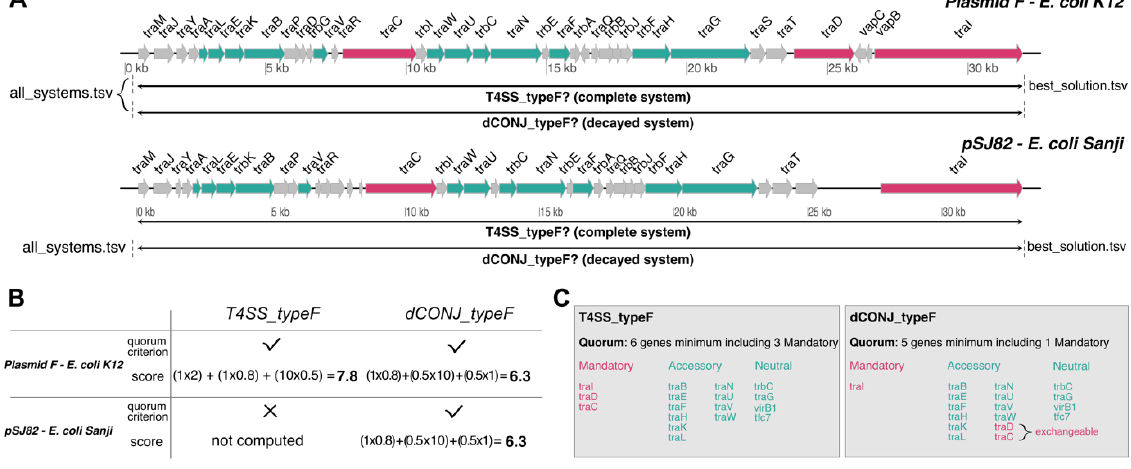
chromosome. (E) The location of the T4aP gene clusters is displayed along the circular chromosome. panel D. In all panels, genes are represented by arrows, their length indicates the gene length, and their direction indicates the gene orientation.